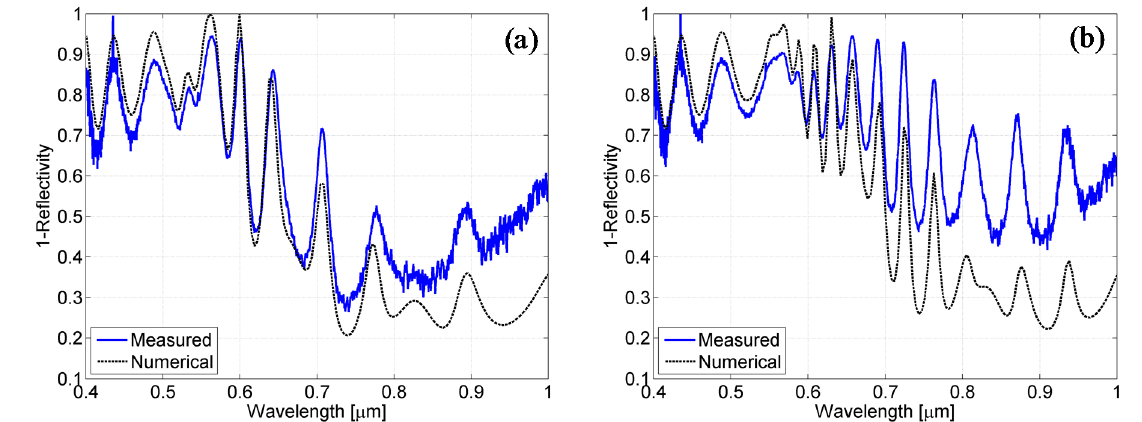
Figure 9. Comparison between simulated (dotted black line) and measured (solid blue line) absorption spectra for the cells grown on flat glass with nominal Si thickness of 800 nm ( a ) and 1500 nm ( b ). From the numerical analysis, a thickness of 800 nm is obtained for the ZnO layer and 780 nm and 1525 nm for the silicon